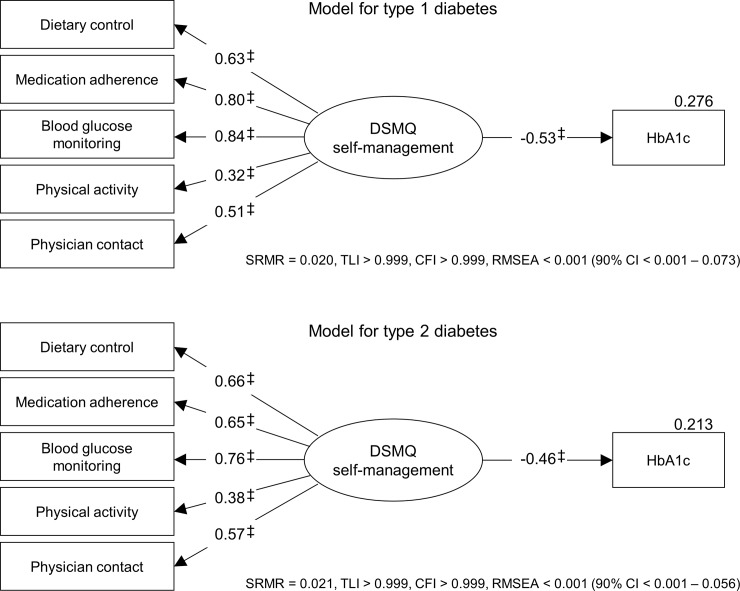
Stuctural equation model of diabetes self-management as measured by the DSMQ and glycaemic control for patients with type 1 and type 2 diabetes.Data are standardised regression weights (β) for paths or squared multiple correlations (R2) for variables. Boxes indicate manifest measurement variables; ovals indicate latent variables operationalised by manifest indicators; error terms are not displayed for ease of presentation. SRMR, Standardised Root Mean Square Residual; TLI, Tucker Lewis Index; CFI, Comparative Fit Index; RMSEA, Root Mean Square Error of Approximation. Indication of two-sided significance: * P < 0.05; † P < 0.01; ‡ P < 0.001.